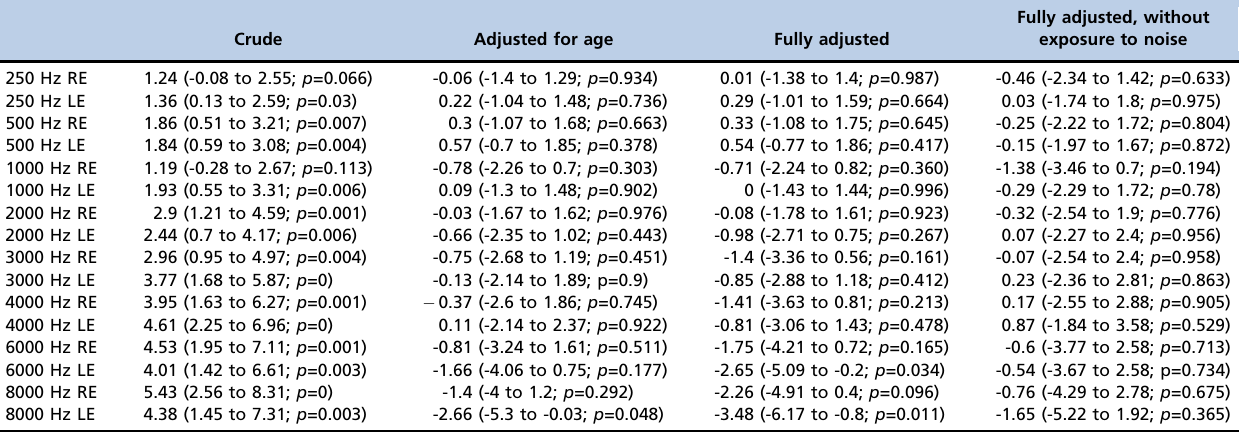
Table 2 - Beta-coefficients for the association between mean audiometric measurements and hypertension in the crude and adjusted models. Crude Adjusted for age Fully adjusted